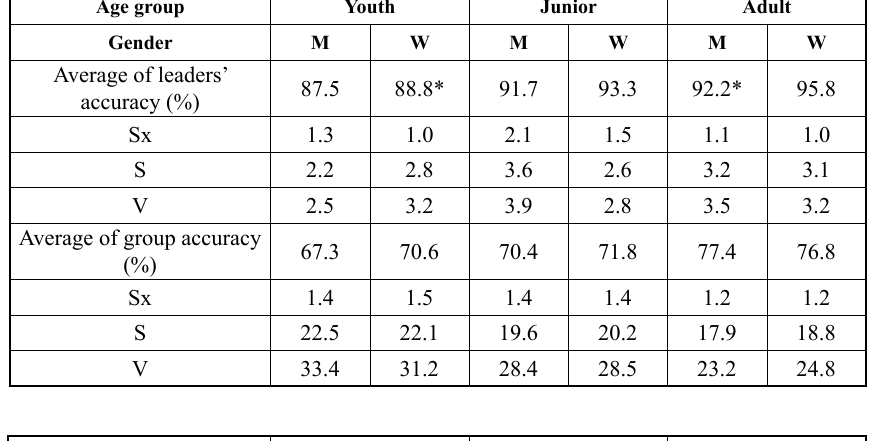
Table 2. Shooting time of various age groups, men (M) and women (W), in prone and stand